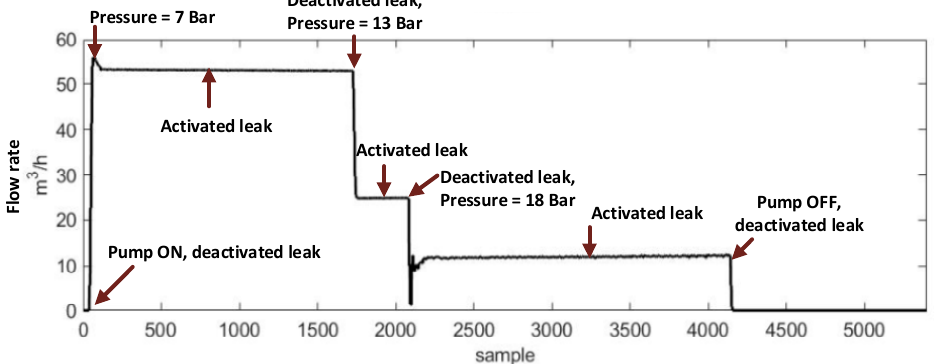
Figure 3. Input flow rate experimented with leak L3.